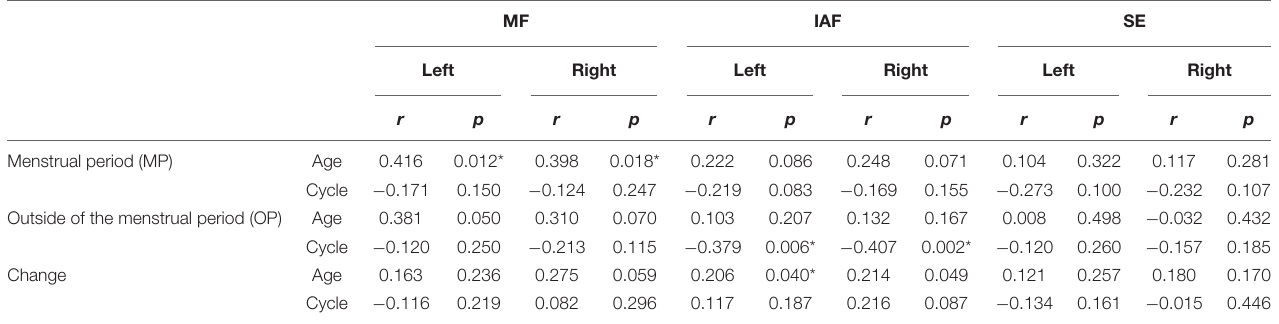
r, average correlation coefficient across bootstrap iterations; p, p-values of weighted bootstrapping statistics, * indicates statistically significant correlation after FDR